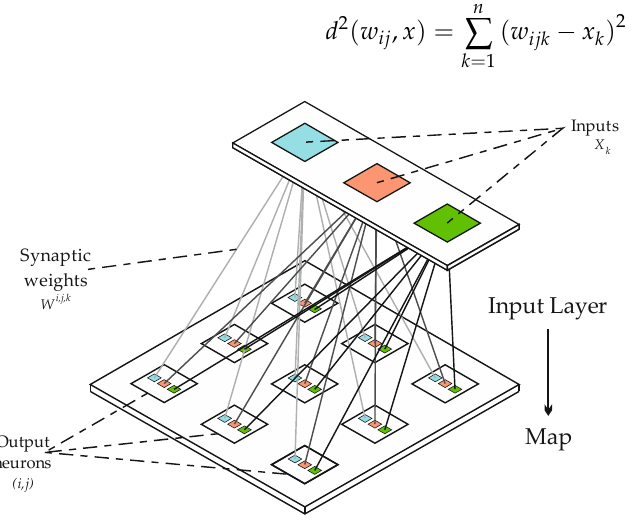
Figure 3. Generic architecture of the SOM. A 3 × 3 output neuron map is shown as an example.